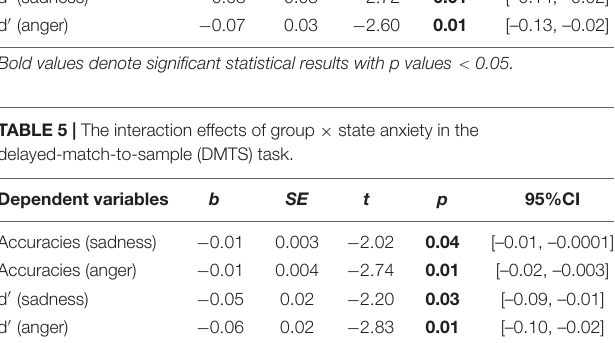
Bold values denote significant statistical results with p values <